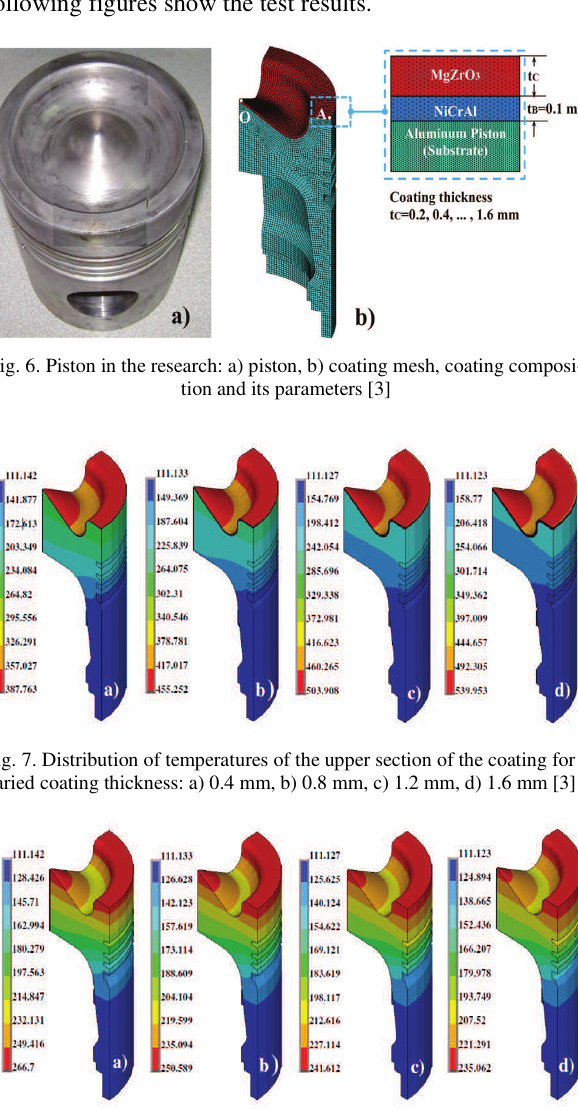
Fig. 8. Distribution of temperatures of the bottom section of the coating for varied coating thickness: a) 0.4 mm, b) 0.8 mm, c) 1.2 mm, d) 1.6 mm